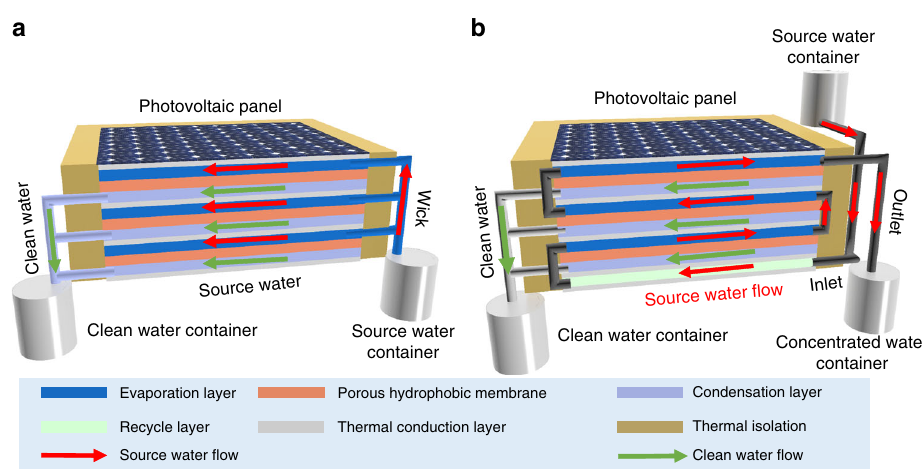
Fig. 1 Schematic illustration of the integrated photovoltaics-membrane distillation (PV-MD) devices. Operate in a dead-end mode (in this mode, the source water is wicked into the evaporation layer in the direction of the red arrow and the condensed water fl ows out from the condensation layer in the direction of the green arrow) and b cross- fl ow mode (in this mode, the source water fl ows to the evaporation layer in the direction of the red arrow and the condensed water fl ows out from the condensation layer in the direction of the green arrow)